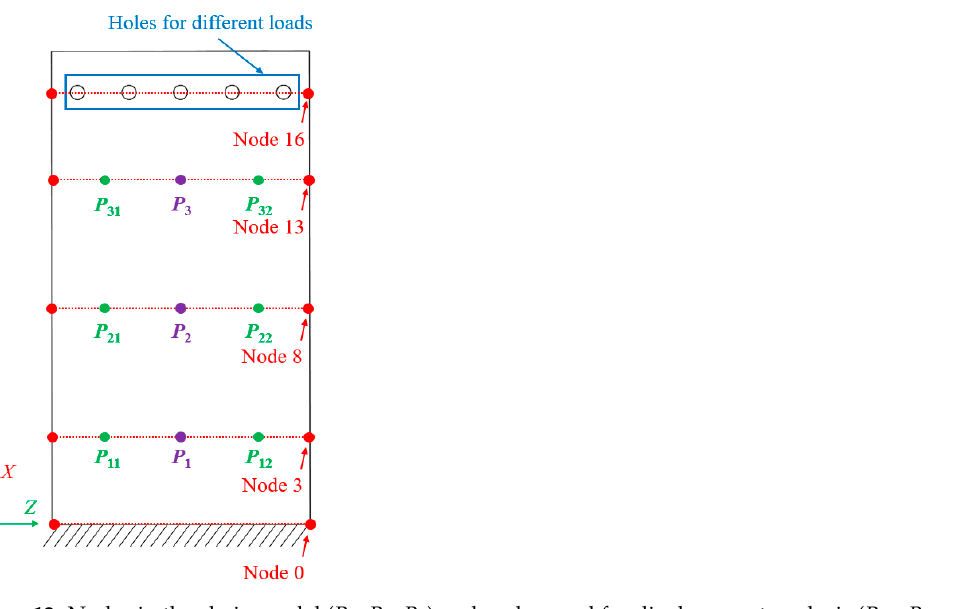
Figure 12. Nodes in the chain model ( P 1 , P 2 , P 3 ) and nodes used for displacement analysis ( P 11 , P 12 , P 21 , P 22 , P 31 , P 32 ). Table 2. Structural parameters.